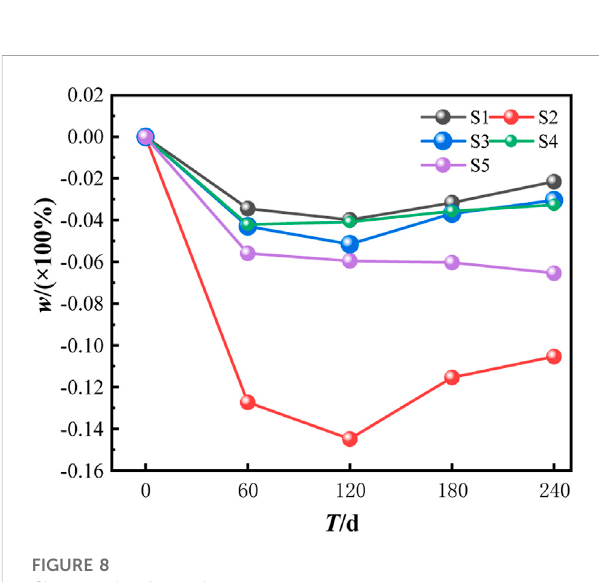
FIGURE 7 Variation rule of water absorption rate.